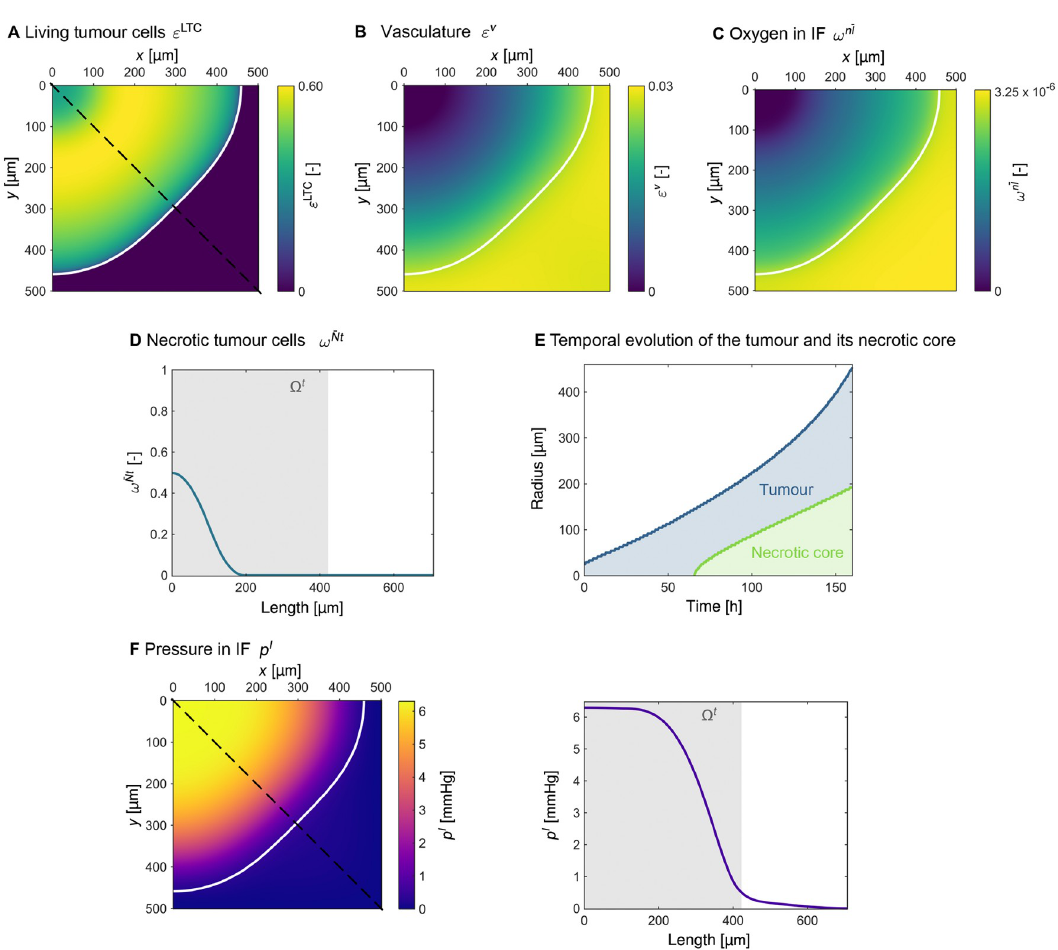
Fig 4. Results of tumour growth after 120 hours. The white contour line indicates the edge of the tumour defined as S t = 0.1. (A) Volume fraction of living tumour cells ε LTC ¼ ε ð 1 (cid:0) o N � t Þ . (B) Volume fraction of vasculature ε v . (C) Mass fraction of oxygen in the interstitial fluid (IF) o n � l . (D) Mass fraction of necrotic tumour cells o N � t visualised over the cut marked by the dashed line in Fig 4A. (E) Temporal evolution of the radius of the tumour and of its necrotic core. (F) Pressure p l in the